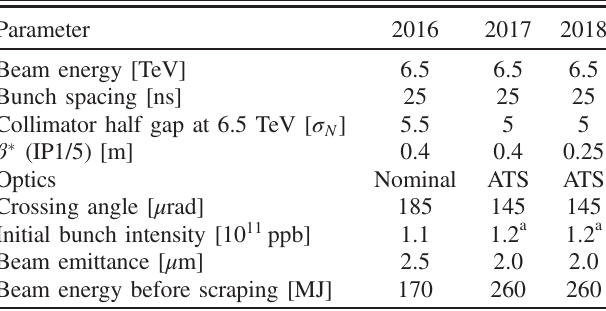
TABLE I. Main ring parameters for the LHC and the beam usual during run 2 for the end-of-fill scraping tests.